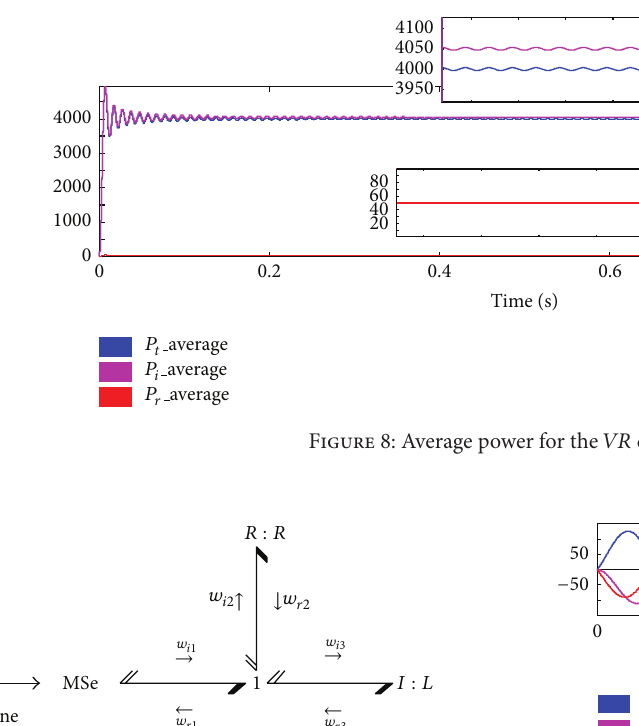
Figure 7: Power waves responses for the 𝑅 -element.